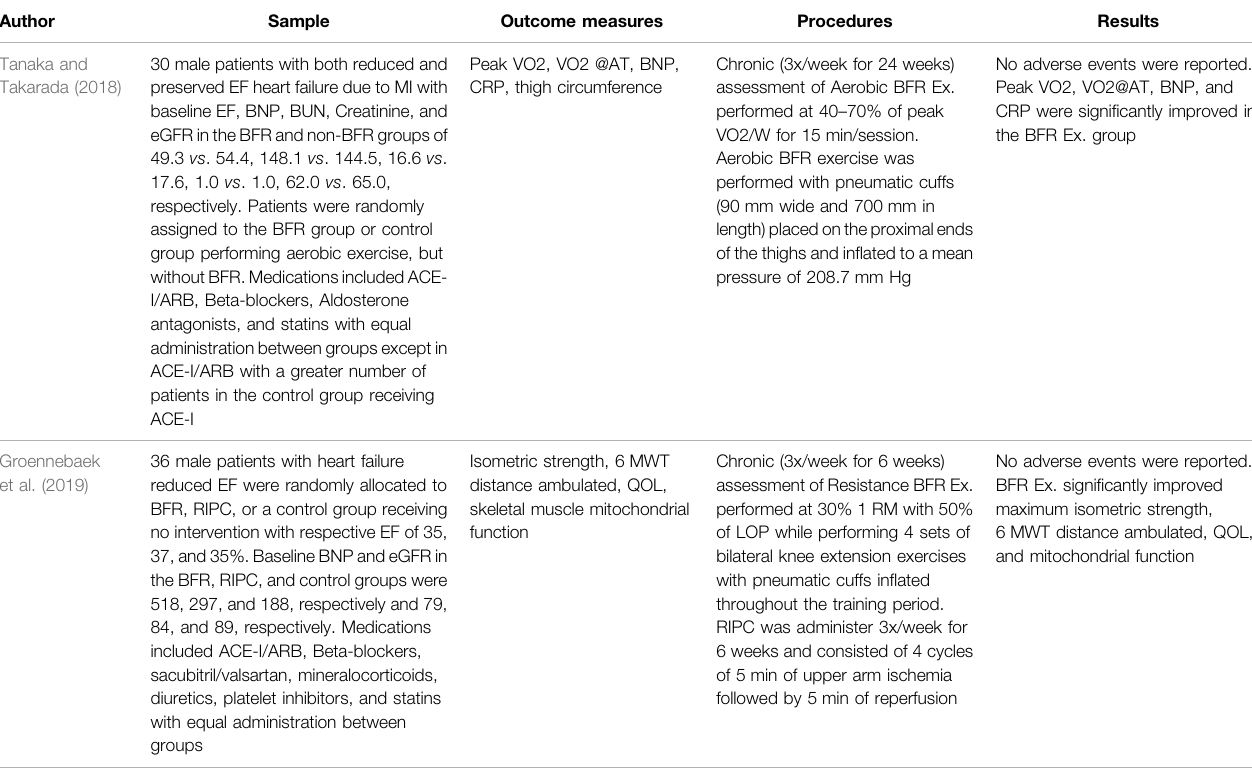
TABLE 3 | Studies of blood fl ow restriction training in patients with heart failure.